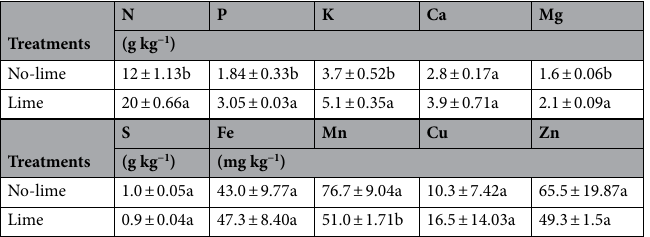
Table 2. Nutrient concentration in wheat seeds from 2014 crop season. Means ± standard error followed by different letter differ by the t-test at 0.05 confidence